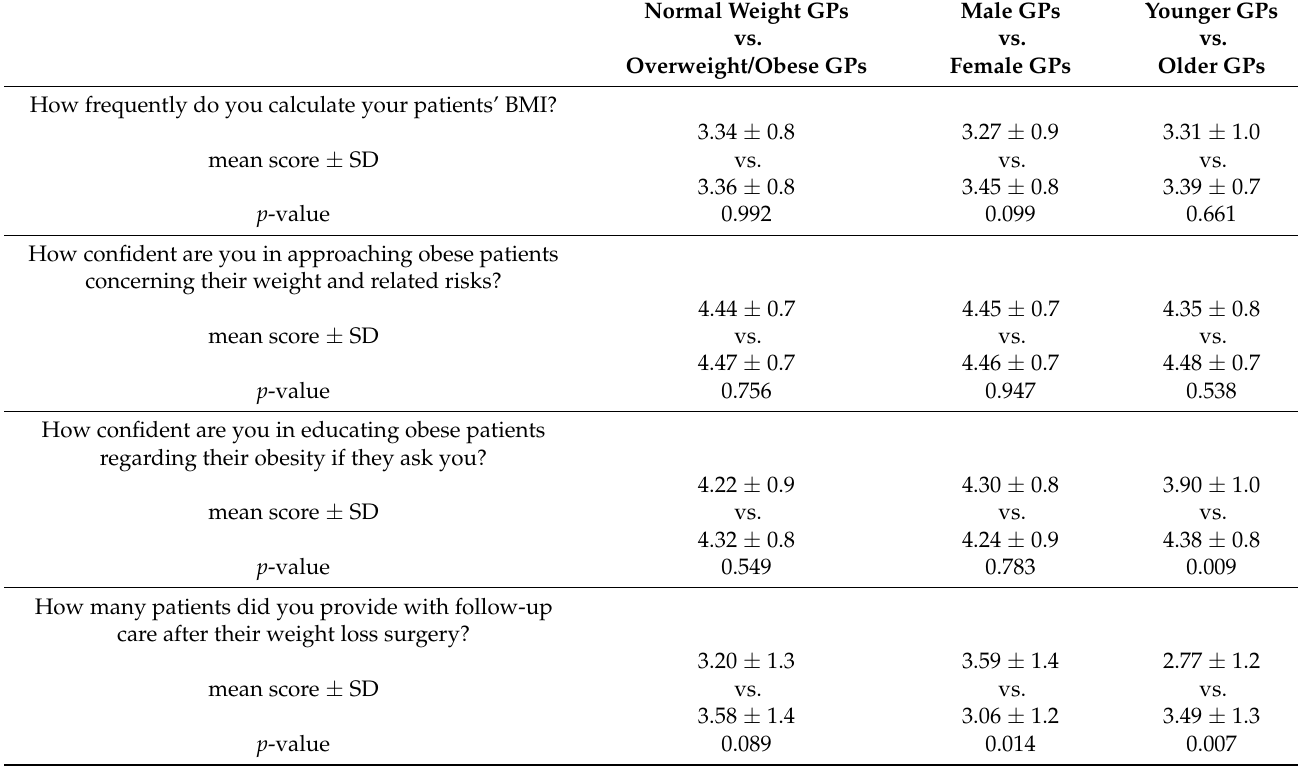
Table 2. General treatment of obese patients in context with GPs’ characteristics.